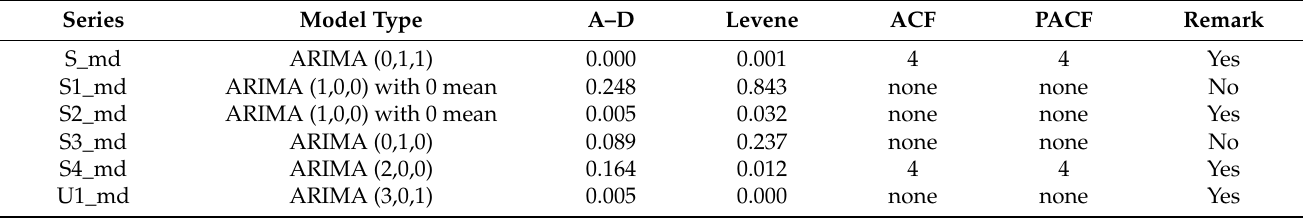
Table 19. Results of the statistical tests on the residual from ARIMA models for the monthly detrended series. Series Model Type